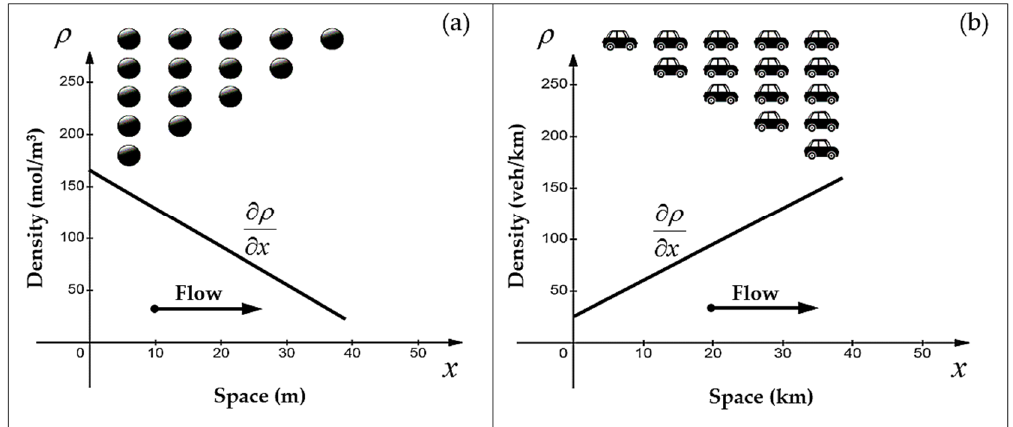
Figure 2. Downhill and uphill dispersion: ( a ) Particles disperse down the density gradient; ( b ) vehicles disperse against the density gradient.